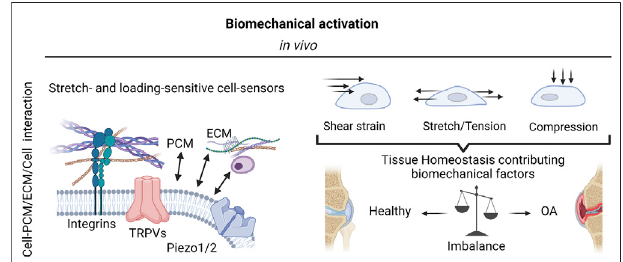
FIGURE 2 | The complexity of biomechanical activation. The mechanosensitivity of knee-joint tissues and resident cells is mediated by integrins as well as stretch- and loading-sensitive cell-bound ion channels (mechanosensors) and include a variety of transient receptor potential (TRP)channels,andothermechanosensitiveionchannelssuchasPiezo1and Piezo 2. These mechanosensors in turn react to a variety of biomechanical forces such as fl uid and mechanical shear strain, stretching, and tensile loading as well as compression to either promote joint tissue physiology or escalate the dysfunctional mechanobiology in OA via pathological mechanosignaling. Created with permissions from